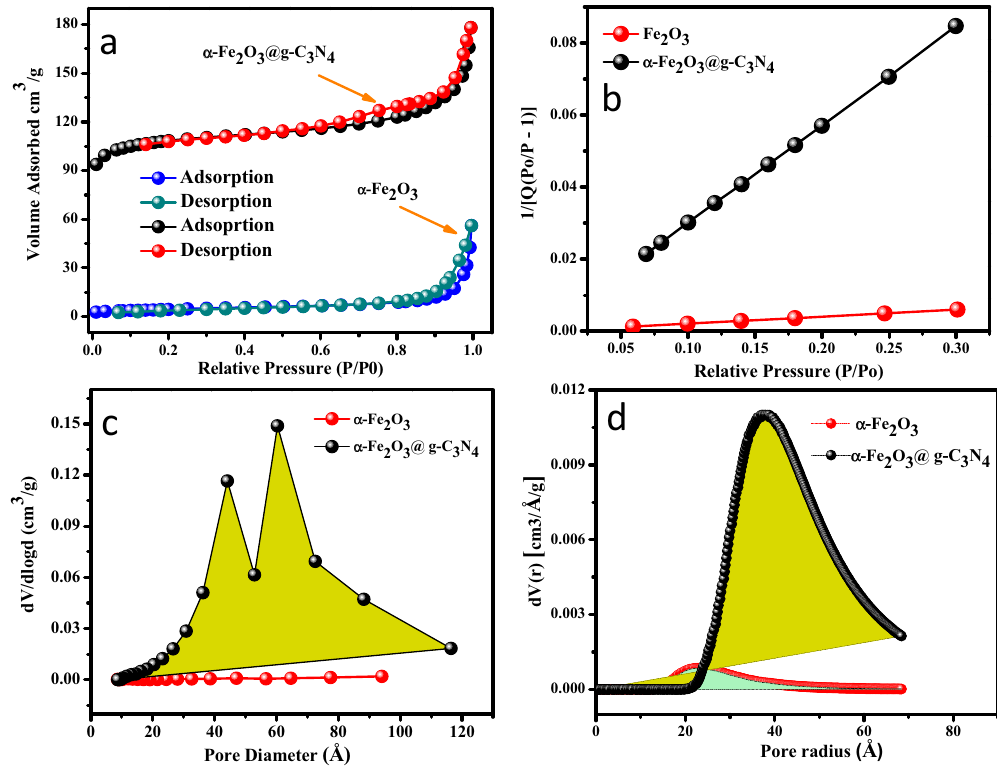
Figure 6. ( a,b ) BET surface area, ( c ) BJH pore size distribution, and ( d ) DA pore size distribution plots of α -Fe α -Fe 2 O 3 -NPs and 2 O 3 @g-C 3 N 4